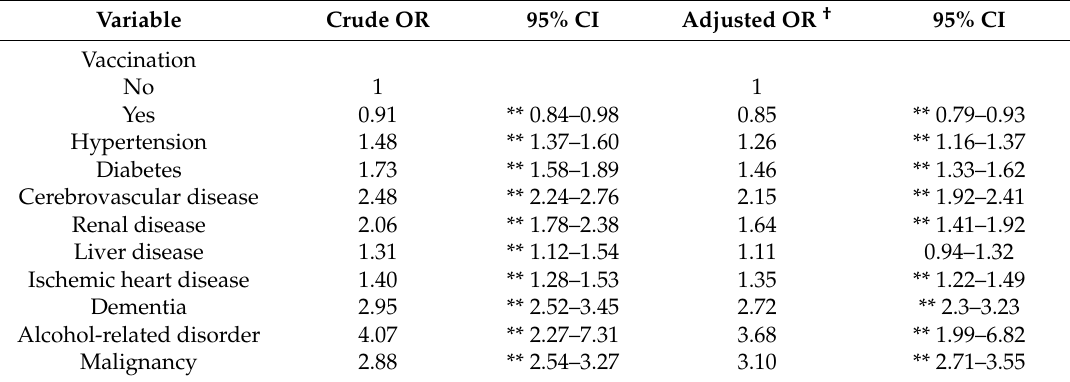
Table 2. Conditional logistic regression between influenza vaccination and comorbidities and the risk of pneumonia.